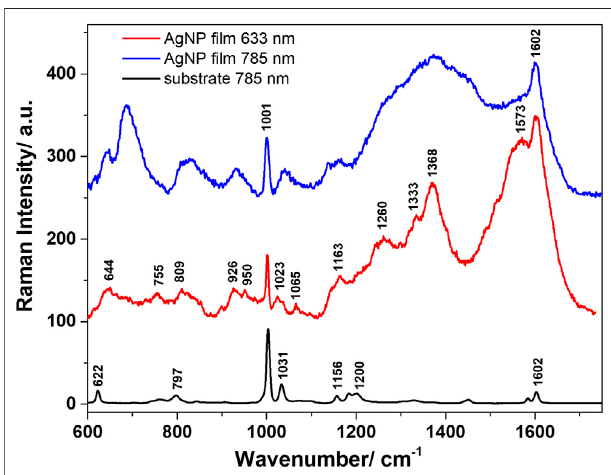
FIGURE 5 | SERS spectra of p-ATP adsorbed on the AgNP fi lm and Raman spectra of bulk p-ATP powder, obtained at different laser excitations: (A) 532 nm, (B) 633 nm, and (C) 785 nm.